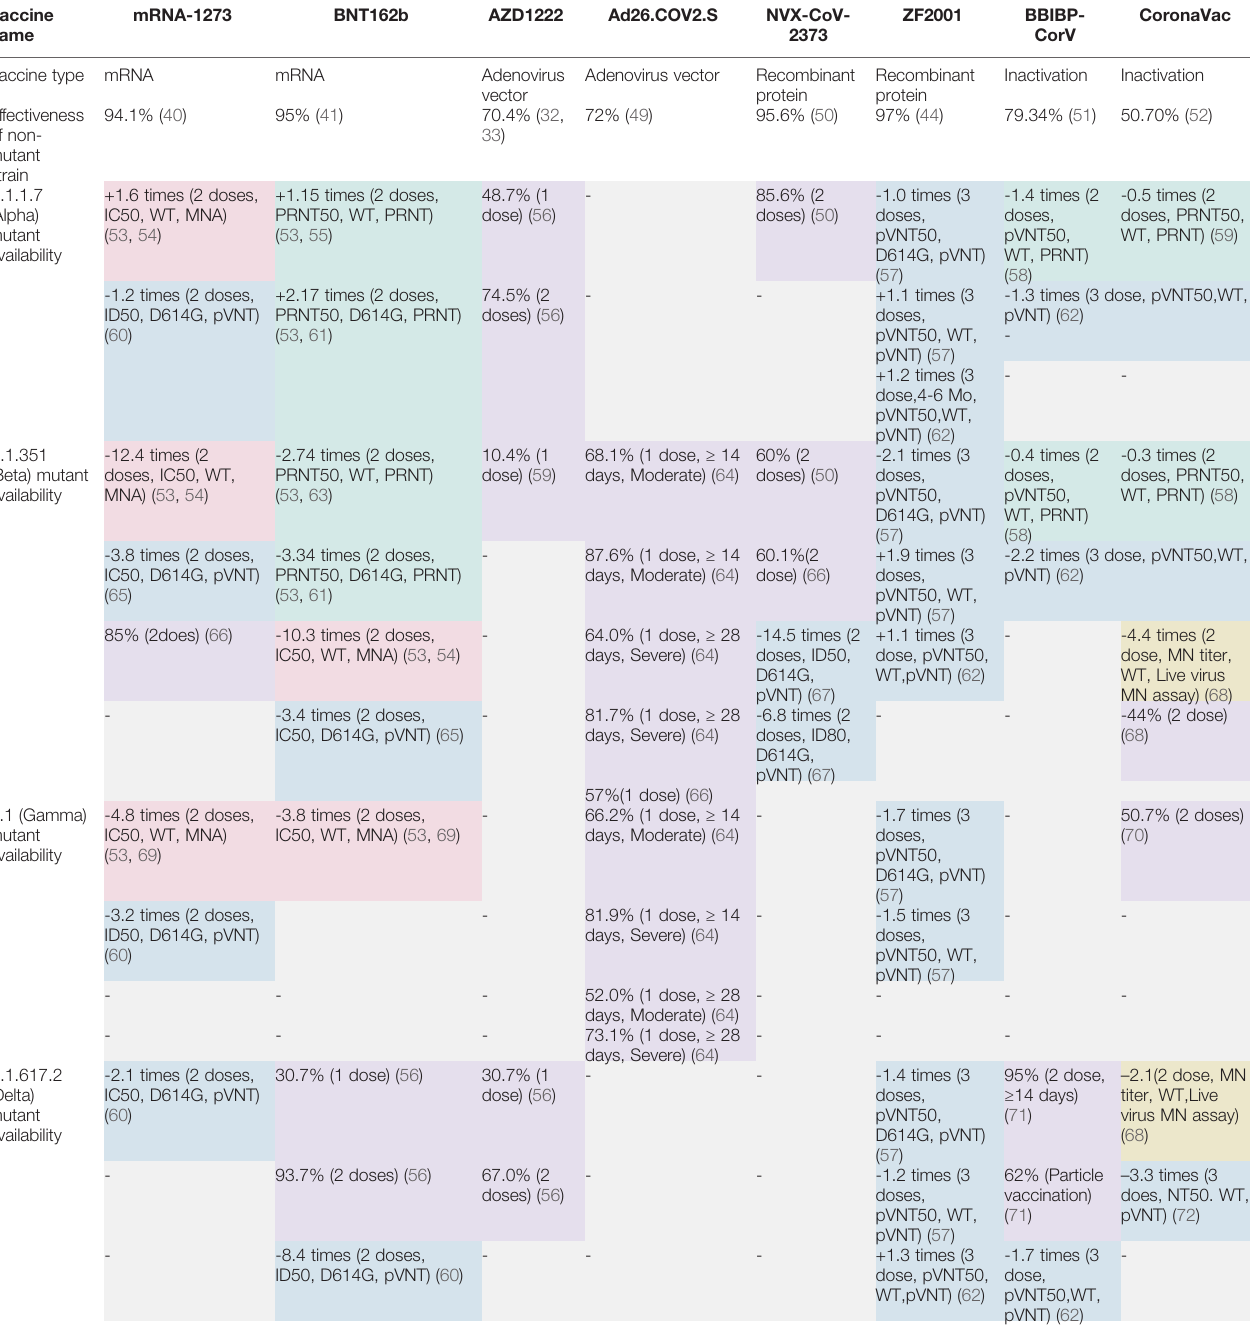
TABLE 2 | The vaccine effectiveness (VE) of various types of vaccines on different